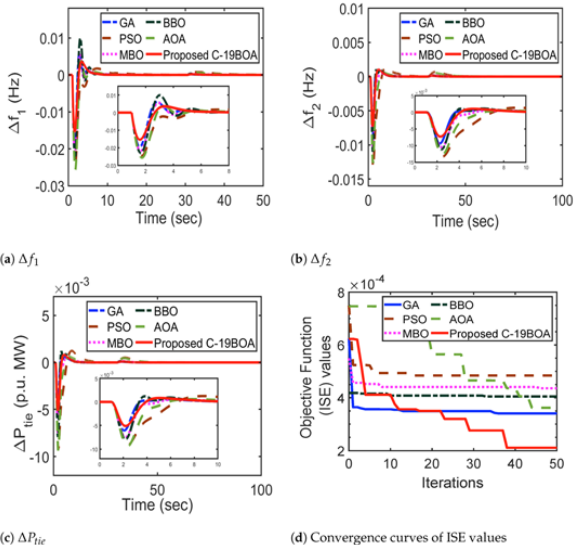
Figure 12. Frequency deviations in Area 1 and Area 2, Tie-line Power Exchange. ( a ) frequency change in area 1, ( b ) frequency change area 2, ( c ) power exchange over the tie-line ( d ) convergence curve of ISE values